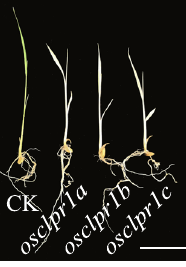
Fig. 3 CRISPR/Cas9-targeted mutagenesis of AL3 . a Mutation of the knockout lines. The 20-bp gene-specific target sequences and PAM are underlined and in red. The number of nucleotides deleted and inserted are indicated by the minus ( − ) and plus (+) signs, respectively. b Comparisons of leaf color in the knockout lines. CK indicates transgenic negative plants. Bars = 5